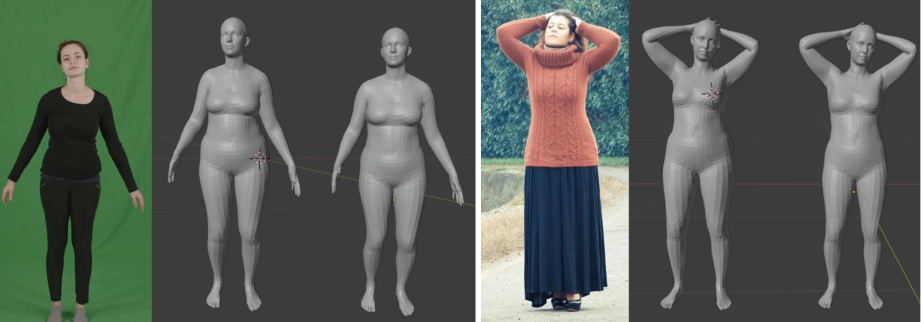
Figure 4. Qualitative examples of body reconstruction from an image of the People Snapshot ( left ) and an “in the wild” image ( right ). The two reconstructions are obtained using the HMR method ( left ) and our approach after Phase 2 ( right ).